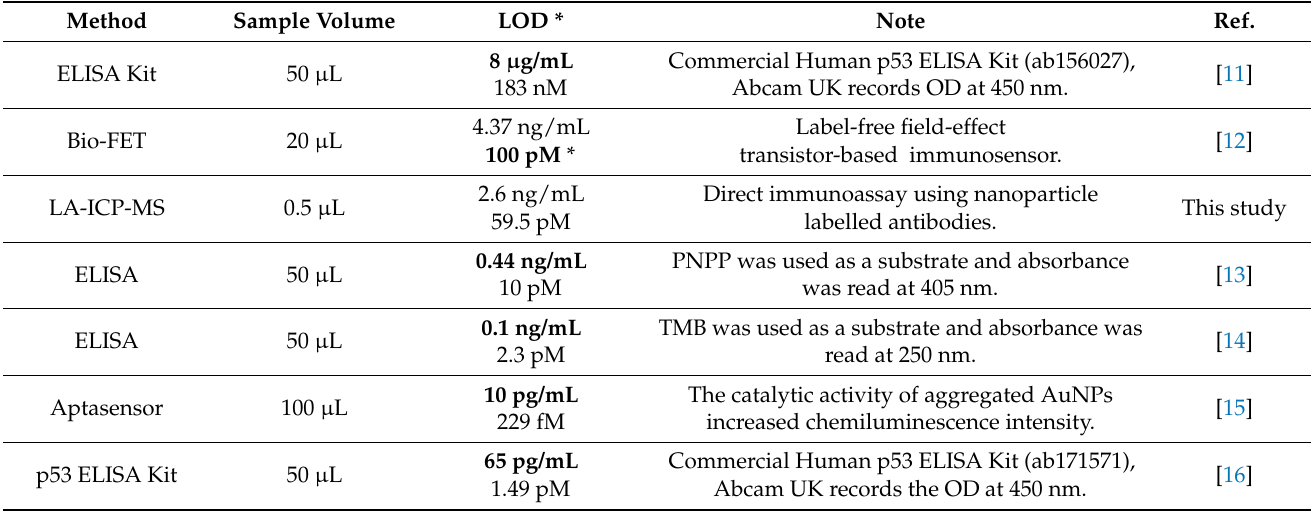
Table 1. Comparison of sample volume and p53 detection limits in different